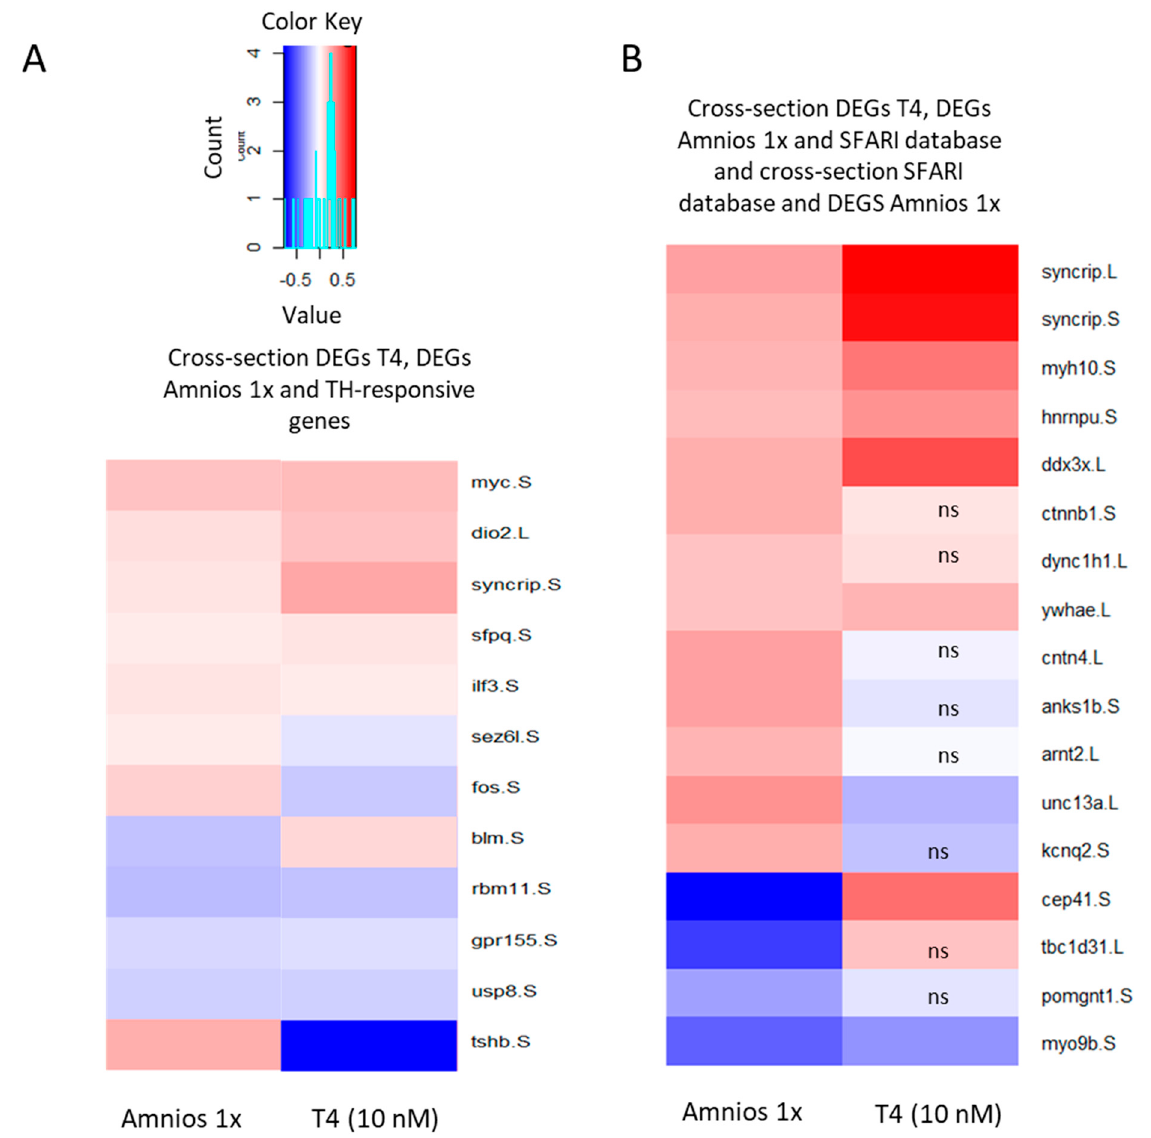
Figure 4. Changes in expression levels of genes specifically affected by amniotic mixture or T 4 treatment. Heatmap depicts the average change in the expression level of genes affected by either amniotic mixture (Amnios 1X) or T 4 (10 nM). Gene names are shown at the right of the heatmap. The color bar represents log2 differences from the control for each treatment. ( A ) DEGs that are in common between T 4 and amniotic treatment as well as TH-responsive genes [22]. ( B ) DEGs that are common between either amniotic mixture and SFARI gene list and DEGs in common between Amnios 1X, T 4 (10 nM), and SFARI gene list. The letters ns stand for non-significant; these genes do not belong to the DEG